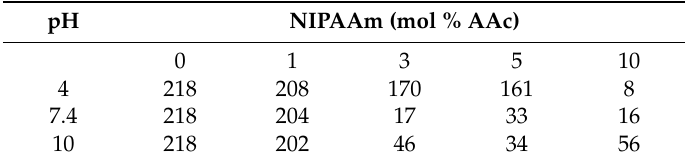
Table 5. Variations of SR (%) for different hydrogels tested from 28 °C to 37 °C.